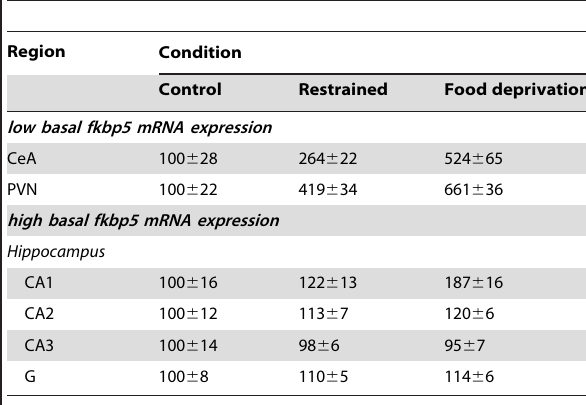
Table 3. Increase in fkbp5 mRNA following different stress paradigms.